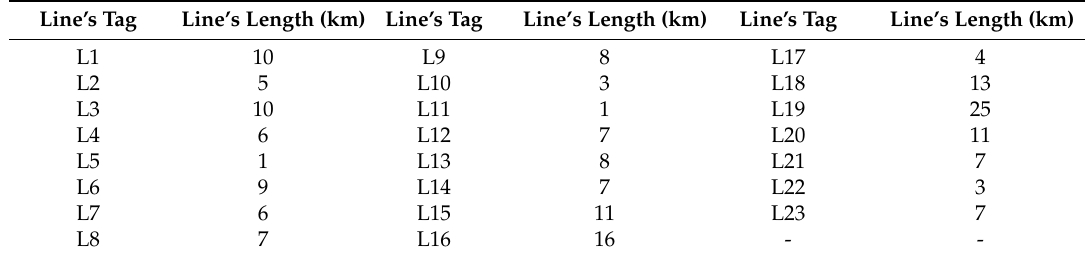
Table 3. Line lengths in power system